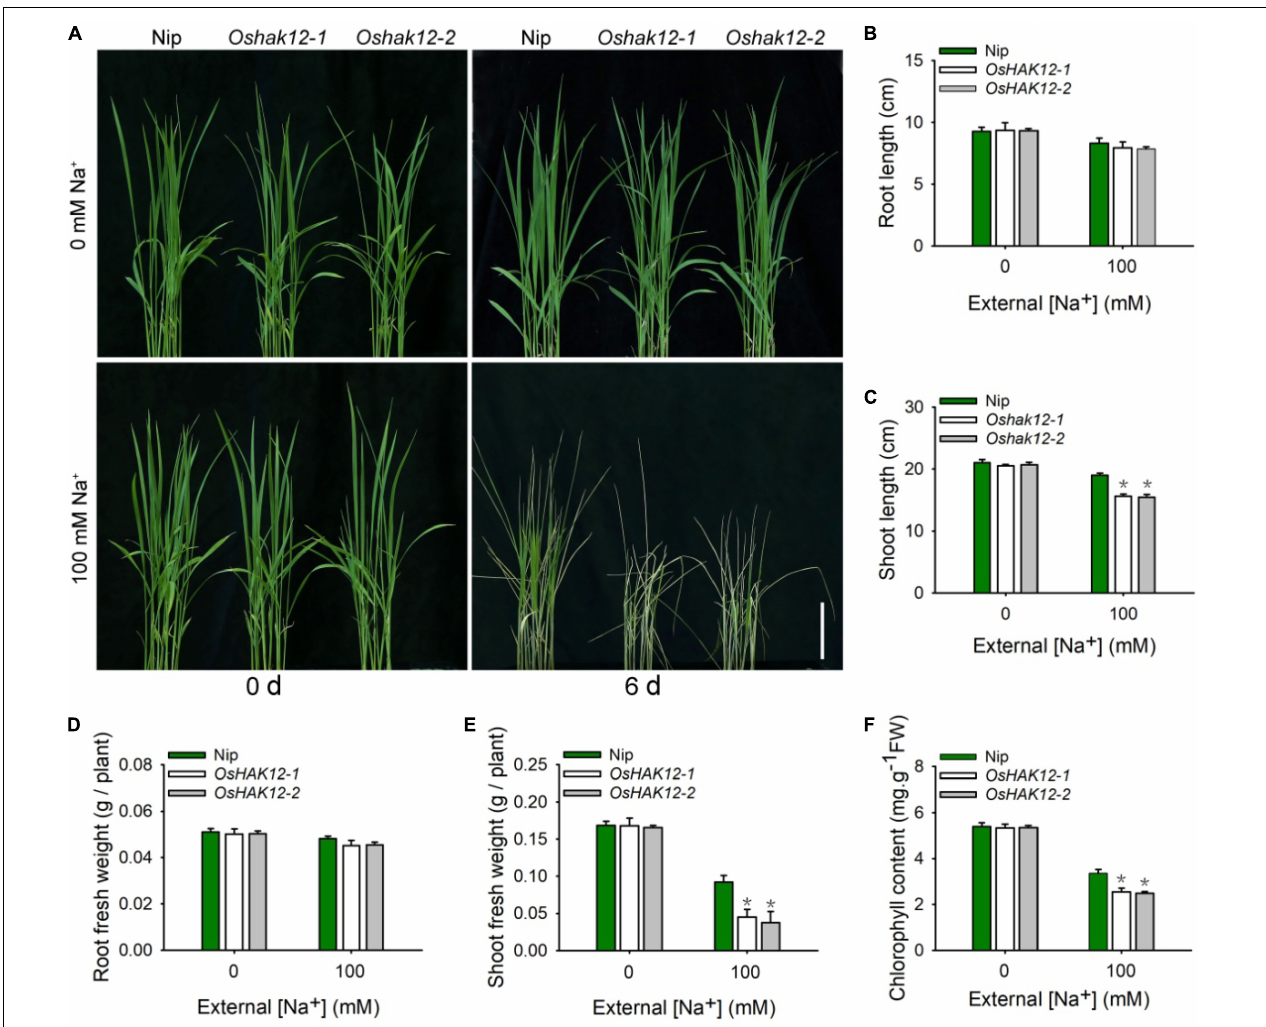
FIGURE 1 | Oshak12 mutants are more hypersensitive to salt stress. (A) Oshak12 mutants are more hypersensitive to salt toxicity. The seeds of the Nip and Oshak12 mutants ( Oshak12-1 , Oshak12-2 ) plants germinated in water for 4 days, after transferred to the hydroponic cultures for 14 days, then transferred to the hydroponic cultures containing 0 or 100 mM Na + for 6 days and photographed. The Oshak12 mutants are more sensitive to salt stress than the Nip. Bars = 6 cm. (B) Root length of the Nip and Oshak12 mutants plants. No significant differences were found between the Nip and Oshak12 mutants ( n = 30 for each data point) ( P > 0.05 by Student’s t -test). (C) Shoot length of the Nip and Oshak12 mutants plants. Significant differences were found between the Nip and Oshak12 mutants ( n = 30 for each data point) (* P < 0.005 by Student’s t -test). (D) Root fresh weight of Nip and Oshak12 mutants plants. No significant differences were found between the Nip and Oshak12 mutants ( n = 30 for each data point) ( P > 0.05 by Student’s t -test). (E) Shoot fresh weight of Nip and Oshak12 mutants plants. Significant differences were found between the Nip and Oshak12 mutants ( n = 30 for each data point) (* P < 0.005 by Student’s t -test). (F) ChlorophyII content of Nip and Oshak12 mutants plants. Significant differences were found between the Nip and Oshak12 mutants ( n = 30 for each data point) (* P < 0.005 by Student’s t -test). Growth conditions were as described in (A) . The experiment was repeated four times with similar results. Data are means of five replicates of one experiment. Asterisks represent significant difference. Error bars represent ±